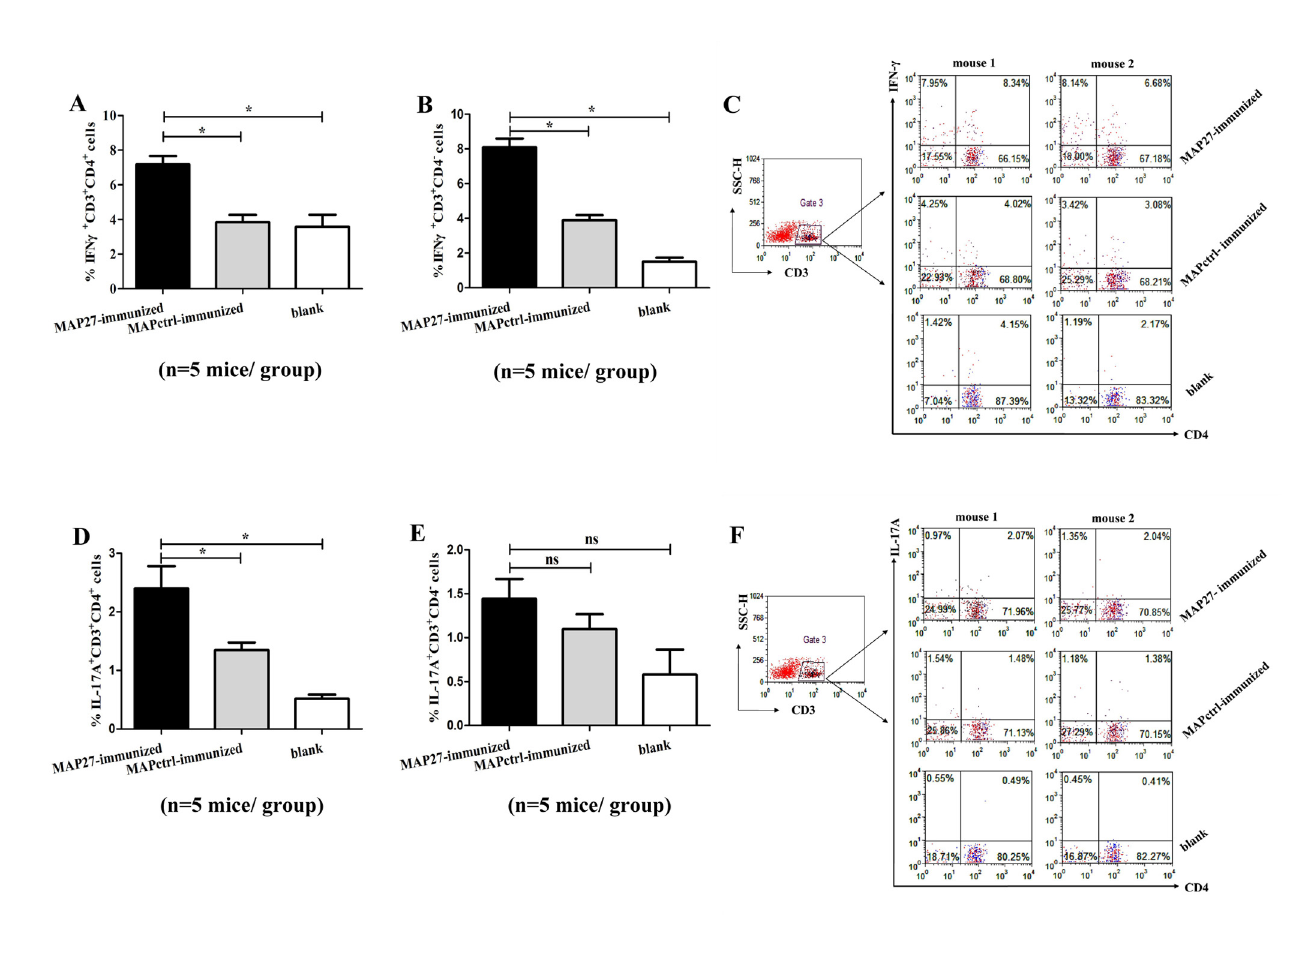
Fig 5. Vaccination with MAP27 primed IFN- γ + CD3 + T cells and IL-17 + CD4 + T cells after S . aureus infection. Five days after the last boost with heat- inactivated S . aureus , all of the mice were infected with S . aureus (2×10 7 CFU/mouse). Spleen cells (n = 5 mice per group) were harvested three days post infection and incubated with cocktail (including PMA and ionomycin) and BFA for 6 h. Cells were then fixed, permeabilized and stained with FITC-anti CD3, APC-anti CD4, PE-anti IFN- γ and PE-anti IL-17A mAb, respectively. Intracellular cytokine analysis was performed by flow cytometry. All lymphocytes were first gated based on FSC and SSC. CD3 + lymphocytes were then further gated from the lymphocyte cluster according to the fluorescence signal intensities. The results were presented as mean ± SEM. (A) The percentage of IFN- γ + CD3 + CD4 + cells. (B) The percentage of IFN- γ + CD3 + CD4 - cells. (C) Representative flow cytometry plots showing the percentage of IFN- γ + CD3 + cells in spleen. (D) The percentage of IL-17A + CD3 + CD4 + cells. (E) The percentage of IL- 17A + CD3 + CD4 - cells. (F) Representative flow cytometry plots showing the percentage of IL-17A + CD3 + cells in spleen. * P < 0.05. ns: not significantly different between two groups (p >